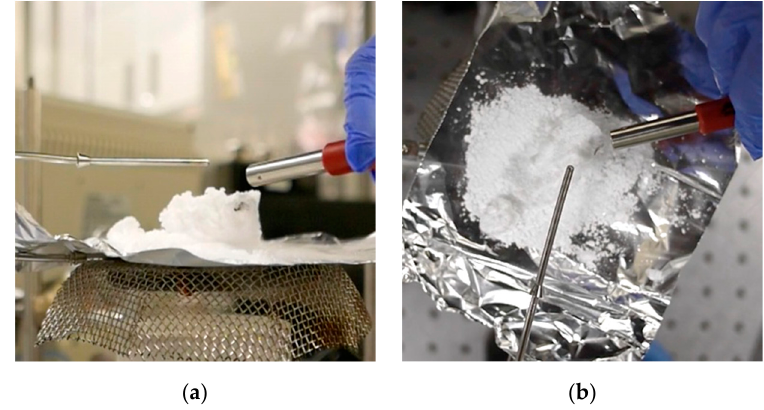
Figure 2. Methane hydrate ignition tests in open air environment, ( a ) side view ( b ) top view.